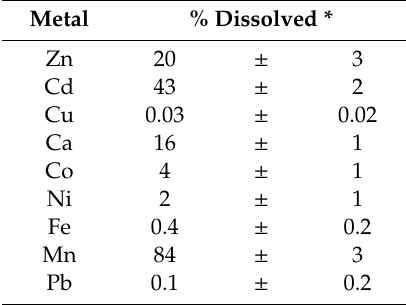
Figure 5. Dissolved proportion of metals in time (25 °C, 15% solids in mass). Table 3. Dissolved metals after 30 min of washing with water (25 °C, 15% solids in mass).